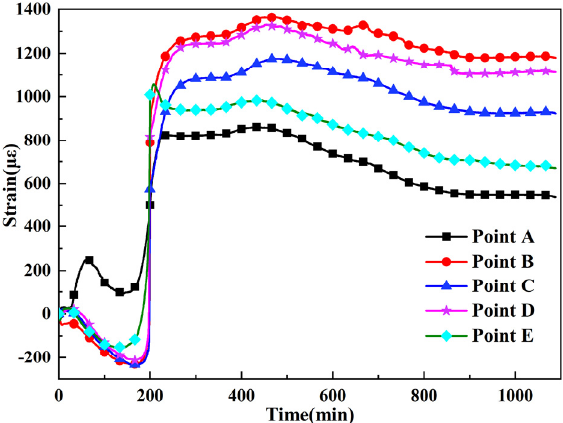
Figure 12. Strain history of thick AF/EP composites.